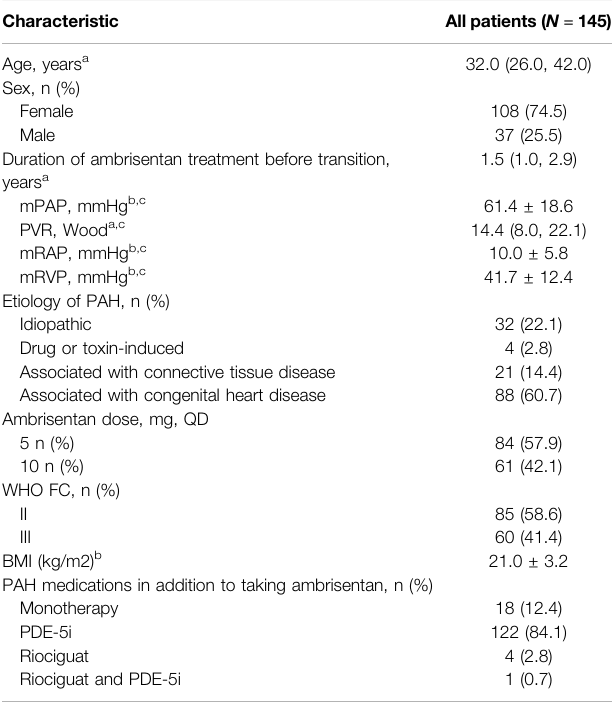
TABLE 1 | Baseline